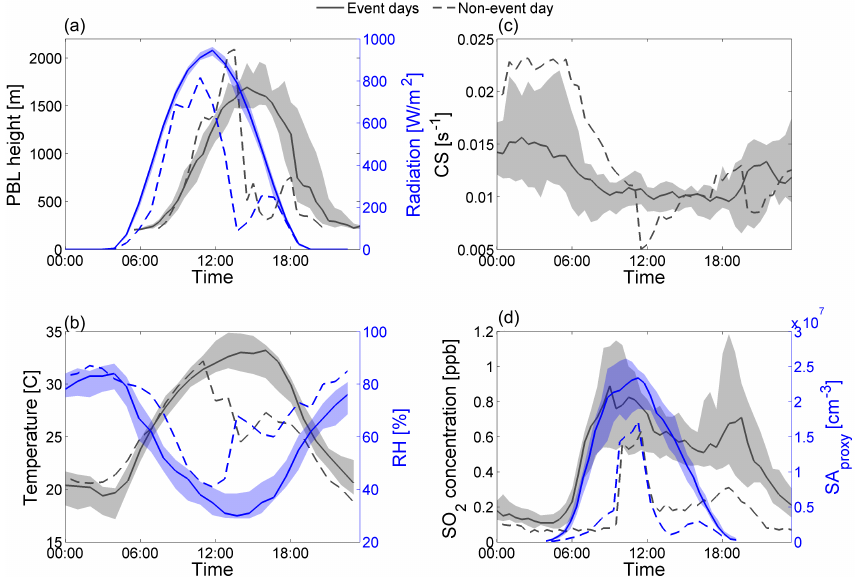
Figure 2. The diurnal variation of different variables during the measurement campaign: (a) PBL height (grey) and global radiation (blue), (b) temperature (grey) and relative humidity (RH; blue), (c) condensation sink (CS), (d) SO 2 concentration (grey) and sulfuric acid proxy (SA proxy ; blue). The median diurnal pattern on NPF event days is shown as solid lines, and the 25th to 75th percentile range as the shaded area. The diurnal variation on the only non-event day (6 July 2012) is shown as dashed lines. Time is UTC +